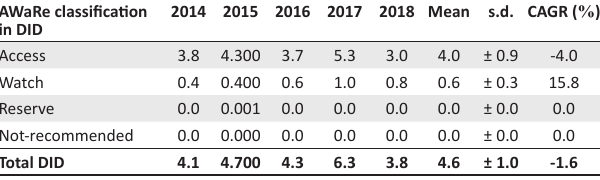
FIGURE 1: Relative antibiotic consumption by Access, Watch and Reserve TABLE 1: Absolute antibiotic consumption by Access, Watch and Reserve classification.